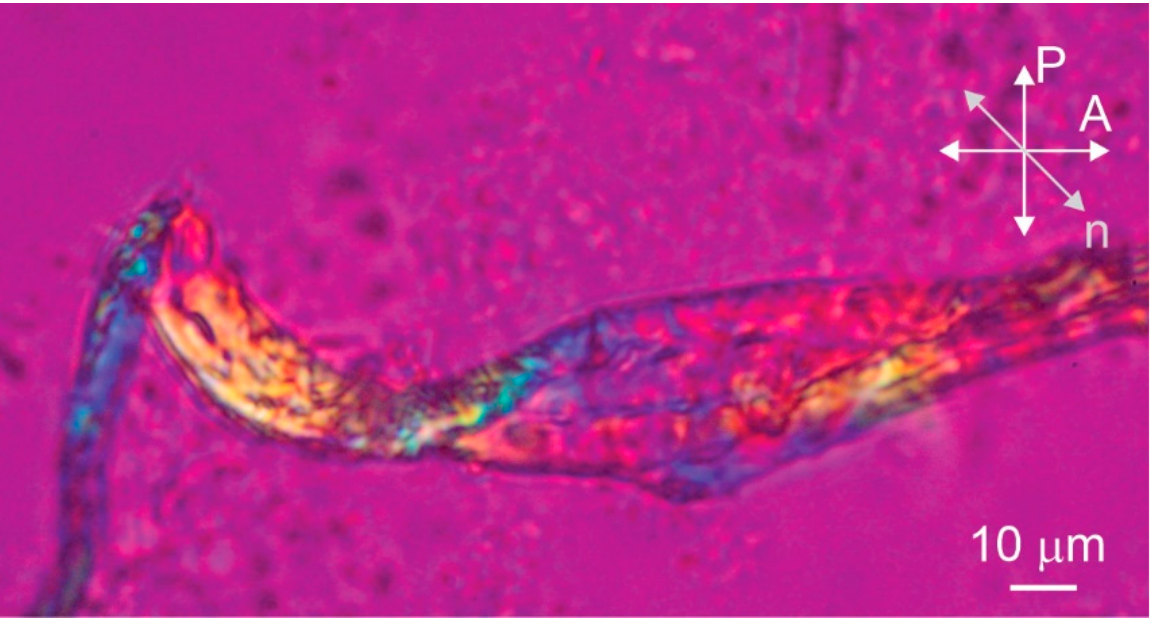
Figure 3. Another entangled bundle of stefin B amyloid fibrils prepared at pH 7.5 observed by polarizing optical microscopy. P and A show the orientations of the polarizer and the analyser, respectively, and n is the direction of the optical axis of the retarder.